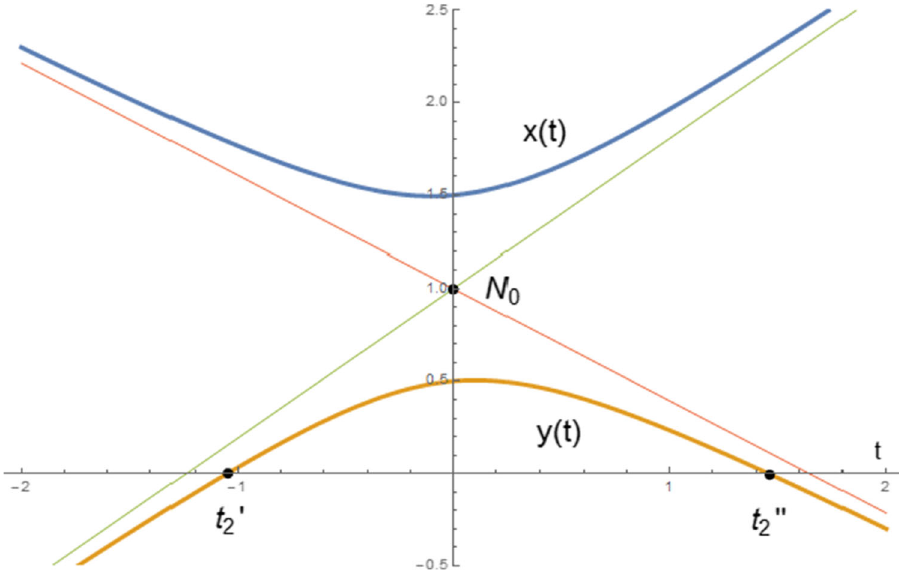
Fig. 3 Evolution of the scale factors of two interacting universes. Case u <